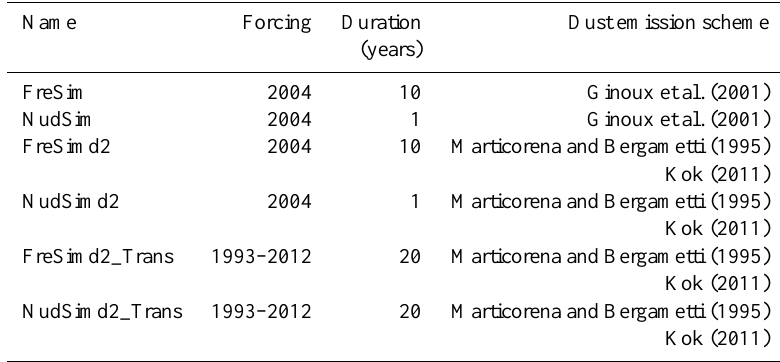
Table 3. Summary of ARPEGE-Climat simulations